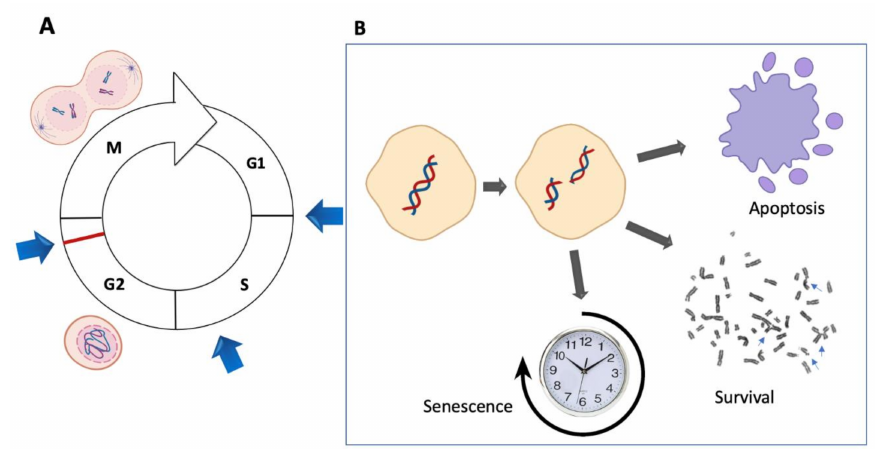
Figure 6. FA cells take cell fate decisions in their transitions through the cell cycle. ( A ) The G1 checkpoint verifies that the cell has the requirements for starting DNA replication, the S phase checkpoint verifies the accurate and timely replication of DNA, the G2 checkpoint verifies that all the chromosomes are correctly replicated and without DNA damage and the M phase checkpoint verifies that chromosomes are correctly aligned to the mitotic spindle before chromosome segregation. Blue arrows indicate moments of interphase cell cycle checkpoints. ( B ) The cell cycle checkpoints are safeguarding moments in which cell fate decisions are taken. For DNA repair deficient cells, such as FA cells, these points are critical since the decision has to be taken whether to activate apoptosis, divide with unrepaired DNA damage or enter into the senescence